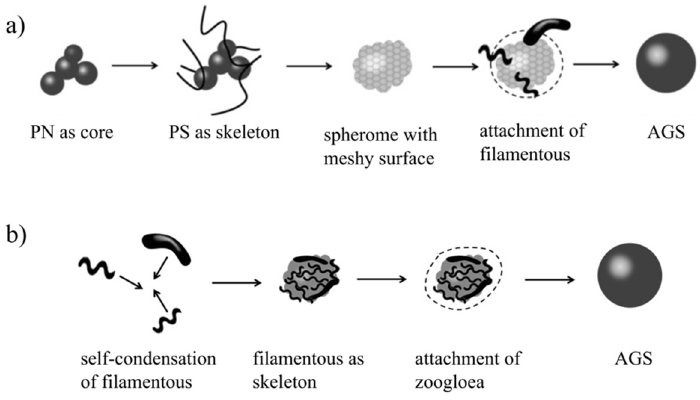
Figure 3. Schematic diagram of granulation process of integrated-type AGS with skeleton of ( a ) EPS and ( b ) filamentous bacteria.